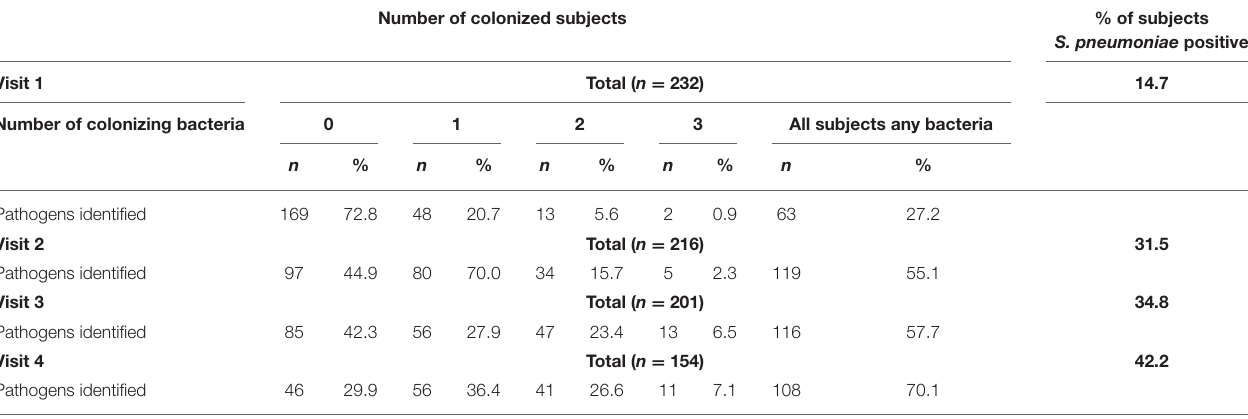
TABLE 2 | Nasopharyngeal colonizing bacterial spectrum in 2–60 month-old children in the course of the study – number of colonized